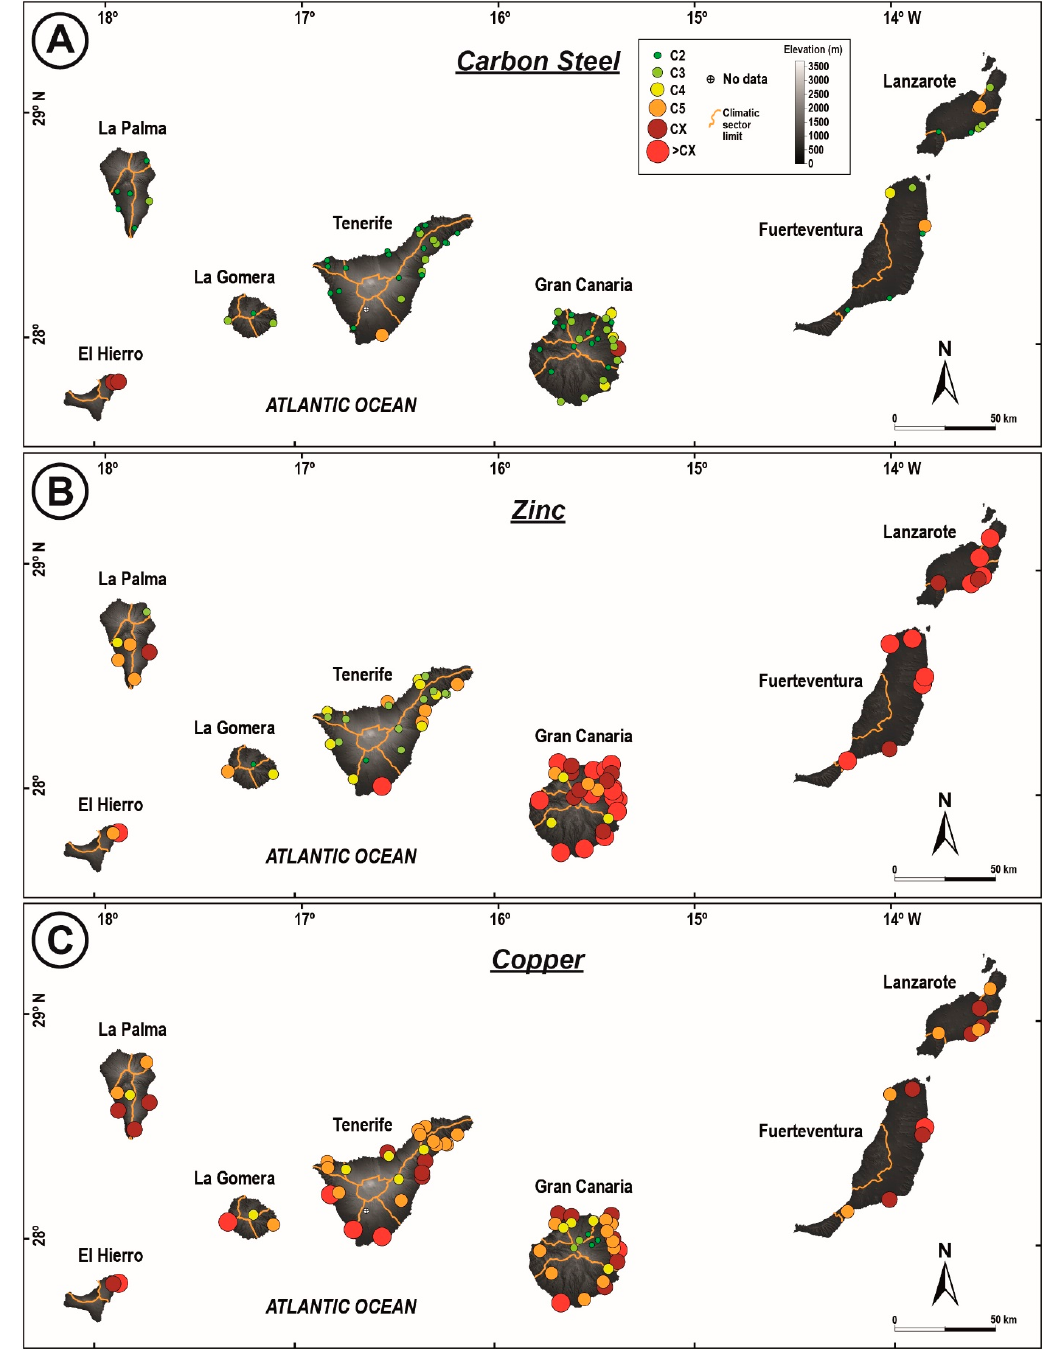
Figure 4. Corrosion maps for ( A ) carbon steel, ( B ) zinc, ( C ) and copper according to ISO 9223:2012